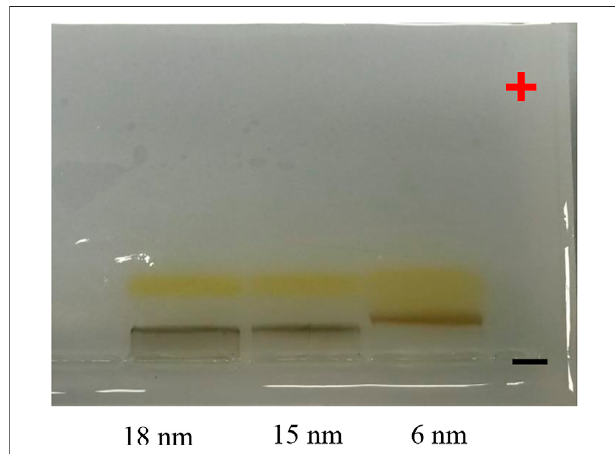
FIGURE5| Photographsofanagarose gelon whichPMA – DDA-coated IONPs of d c (cid:2) 6, 15, and 18 nm had been run for 1 h at 100 V. For this, the IONP samples had fi rst been mixed with Orang-G-containing loading buffer, before they had been loadedinto a2% agarose gel.After theapplication of voltage, the negatively charged NPs run toward the positive pole.